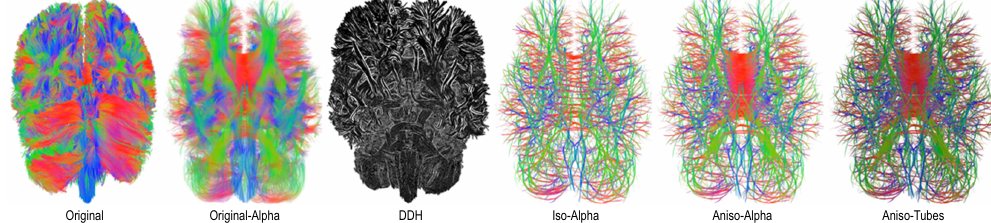
Figure 14. Six bundling-and-rendering variations used to evaluate our